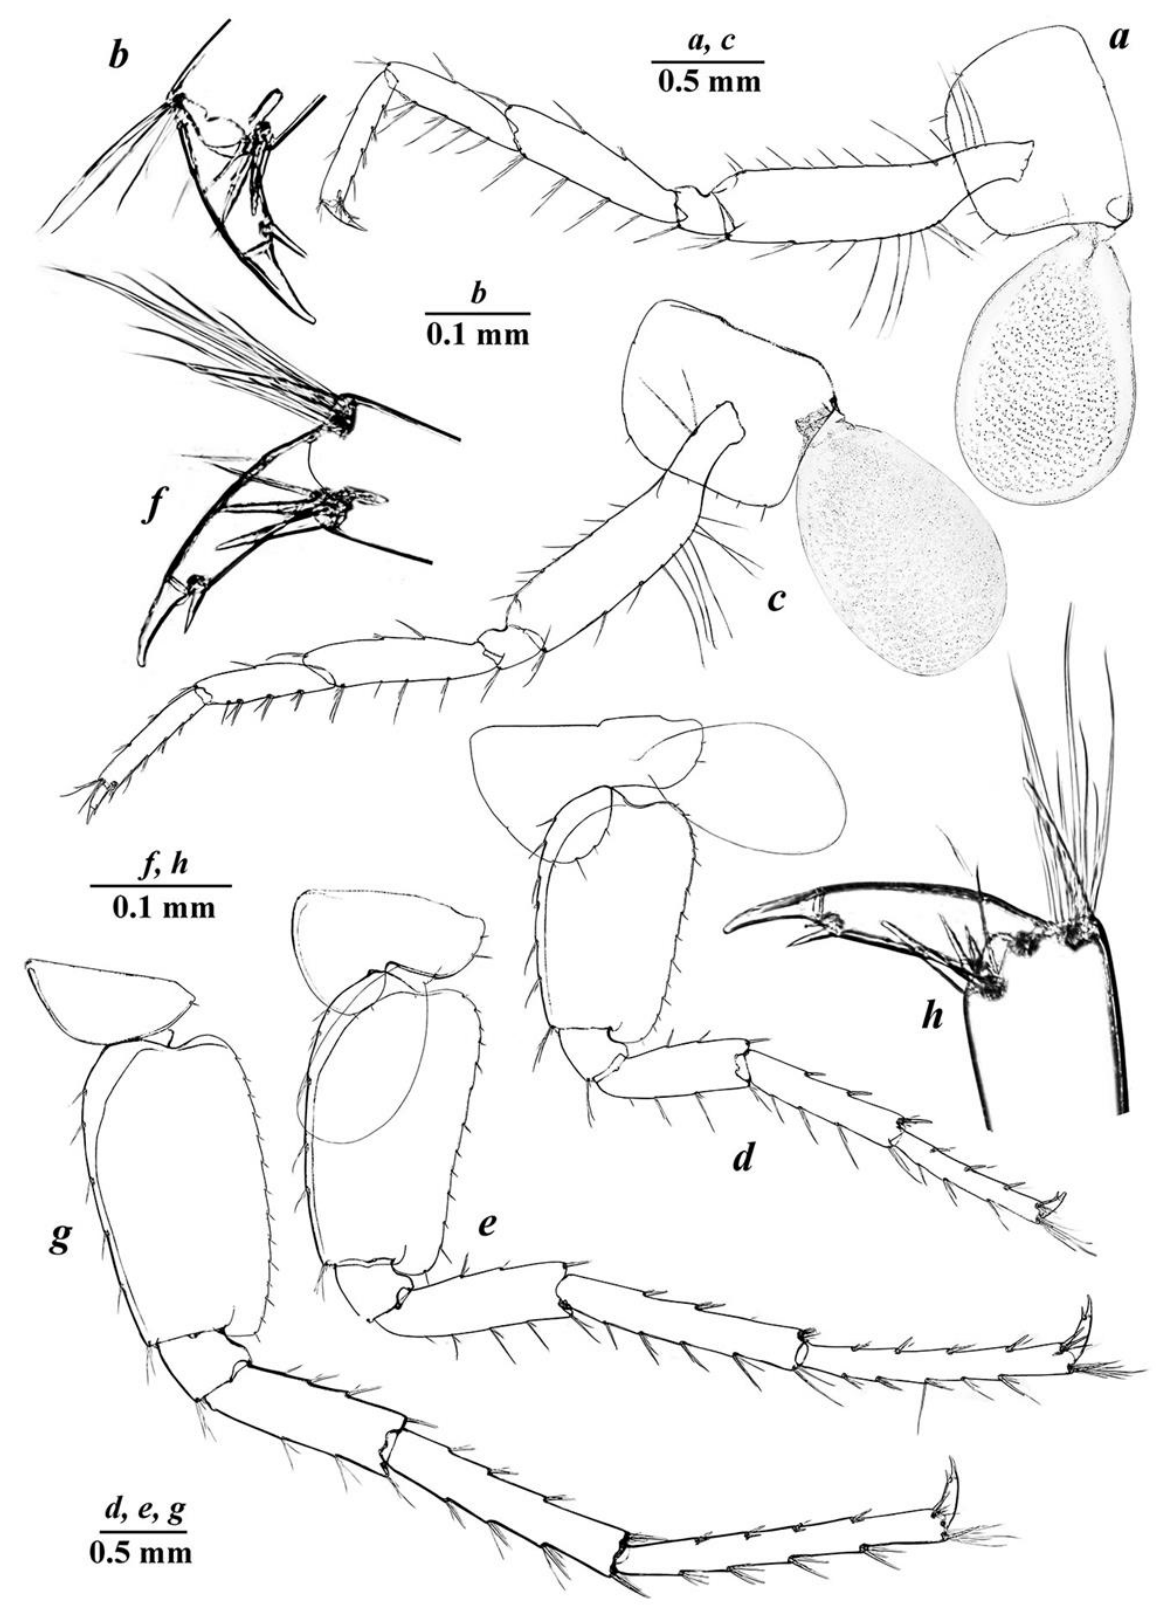
Figure 5. Niphargus tarkhankuticus sp. nov., male: ( a ) pereopod III; ( b ) dactylus of PIII; ( c ) pereopod IV; ( d ) pereopod V; ( e ) pereopod VI; ( f ) dactylus of pereopod VI; ( g ) pereopod VII; ( h ) dactylus of pereopod VII.